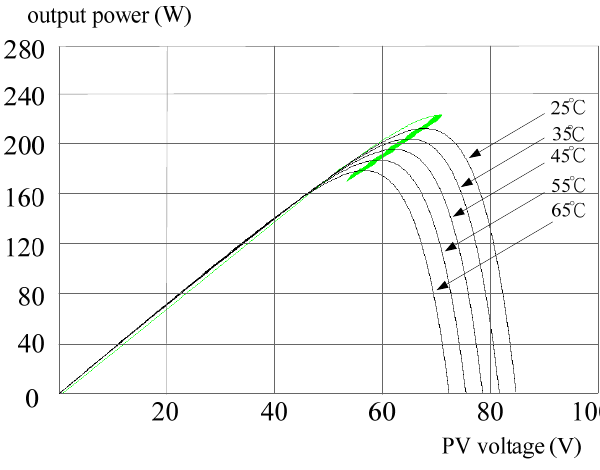
Figure 13. MPPT trajectory by the DLAA under constant irradiation.